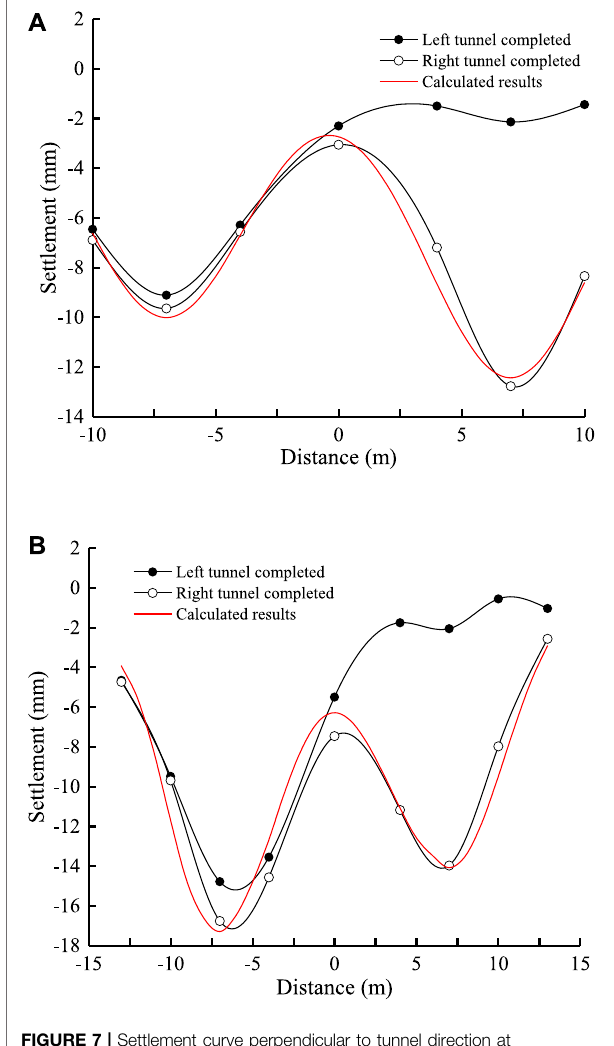
FIGURE 7 | Settlement curve perpendicular to tunnel direction at different sections: (A) D2 and (B)